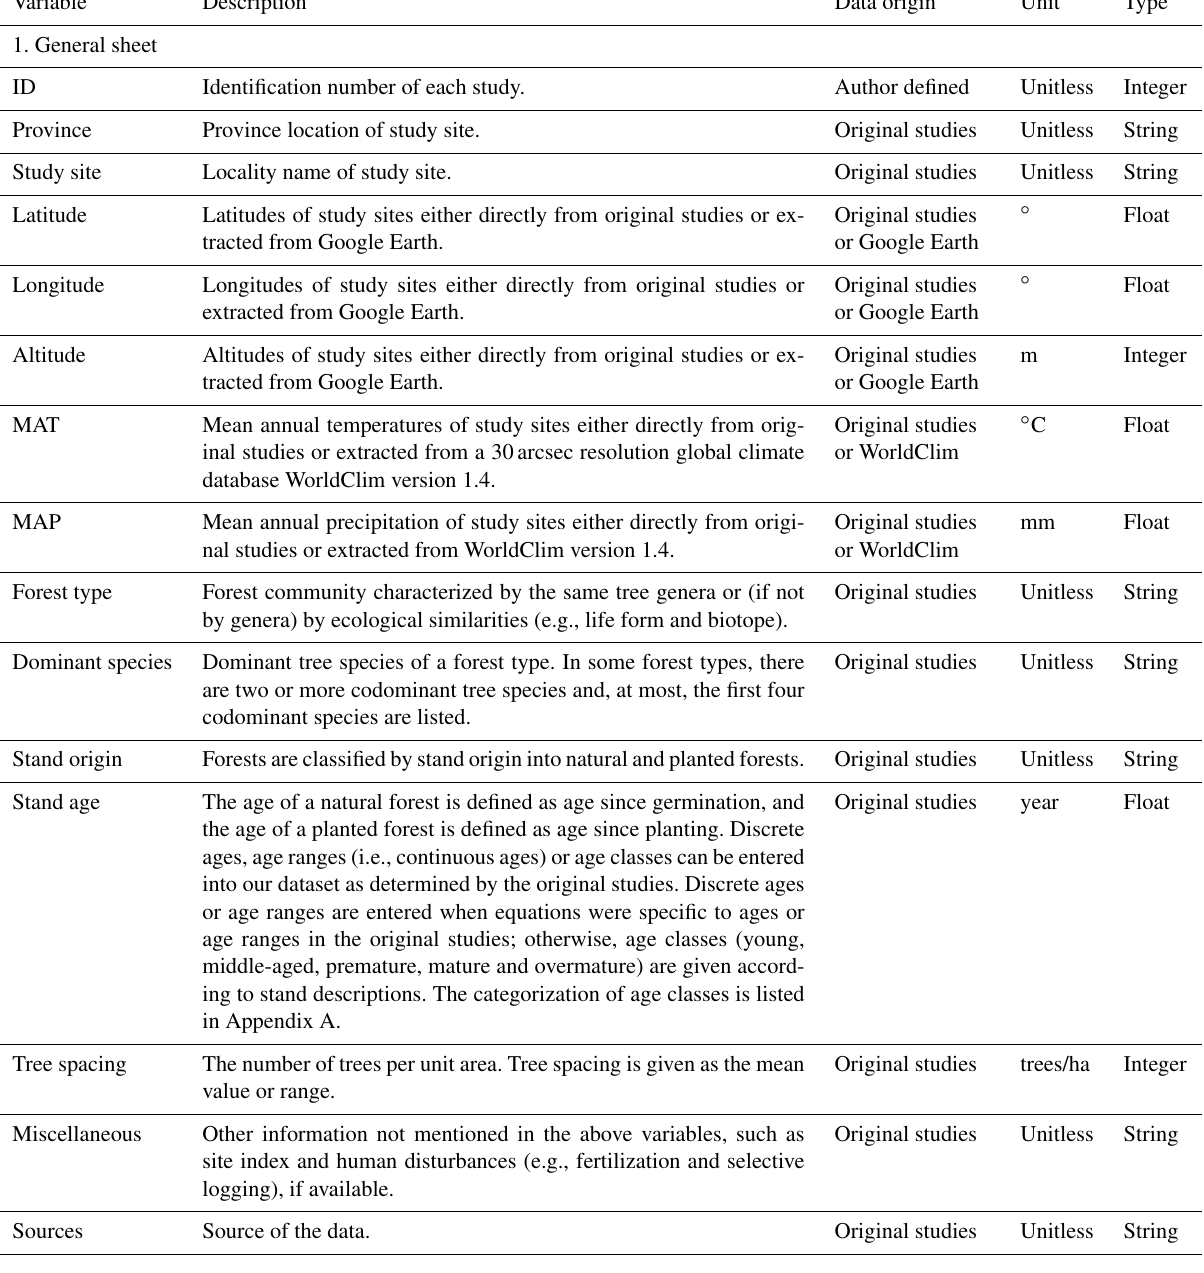
Table 1. Summary of variable information in the dataset, which is available at https://doi.org/10.1594/PANGAEA.895244 (Luo et al., 2018).